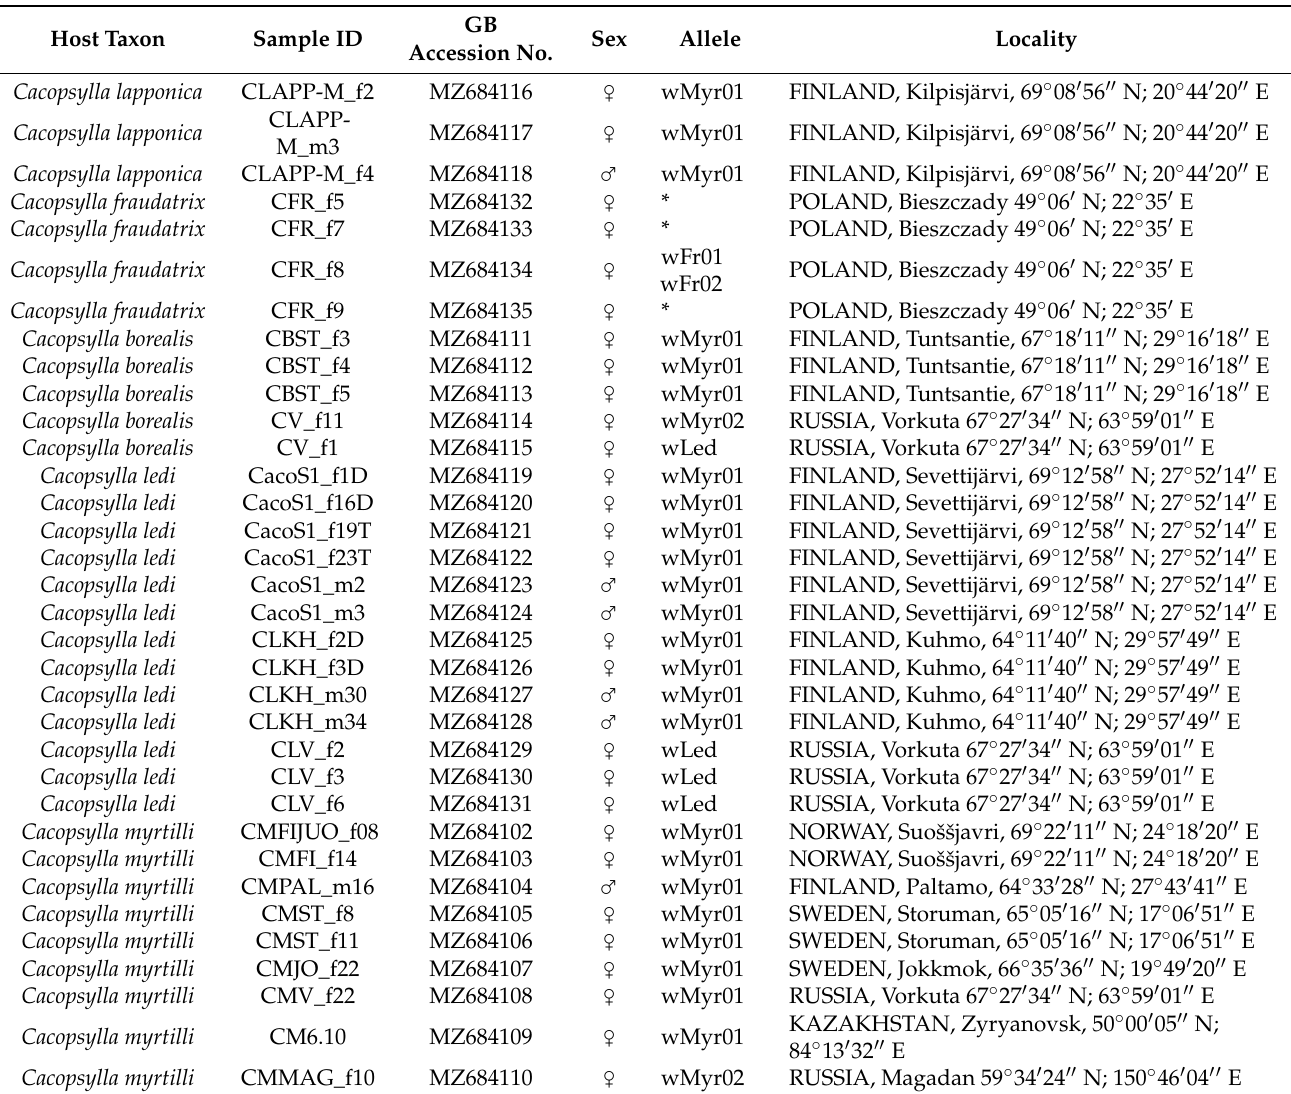
Table 2. List of specimens sequenced for Wolbachia wsp gene.